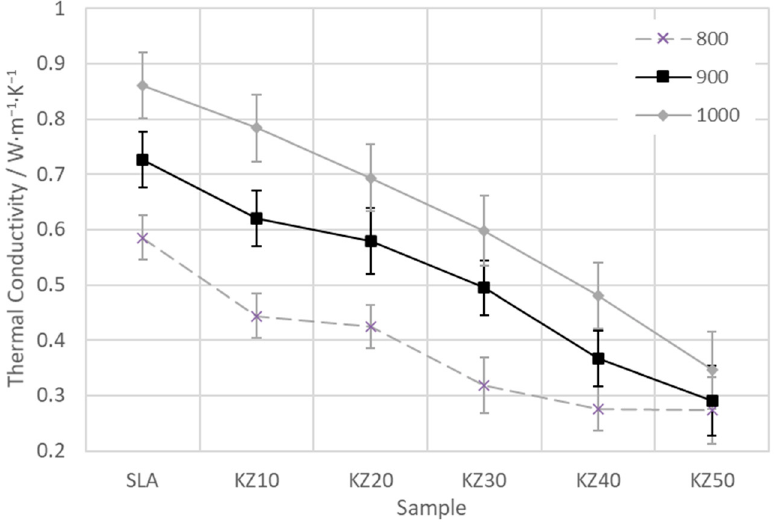
Figure 15. Thermal conductivity of the studied samples at 800, 900, and 1000 °C.